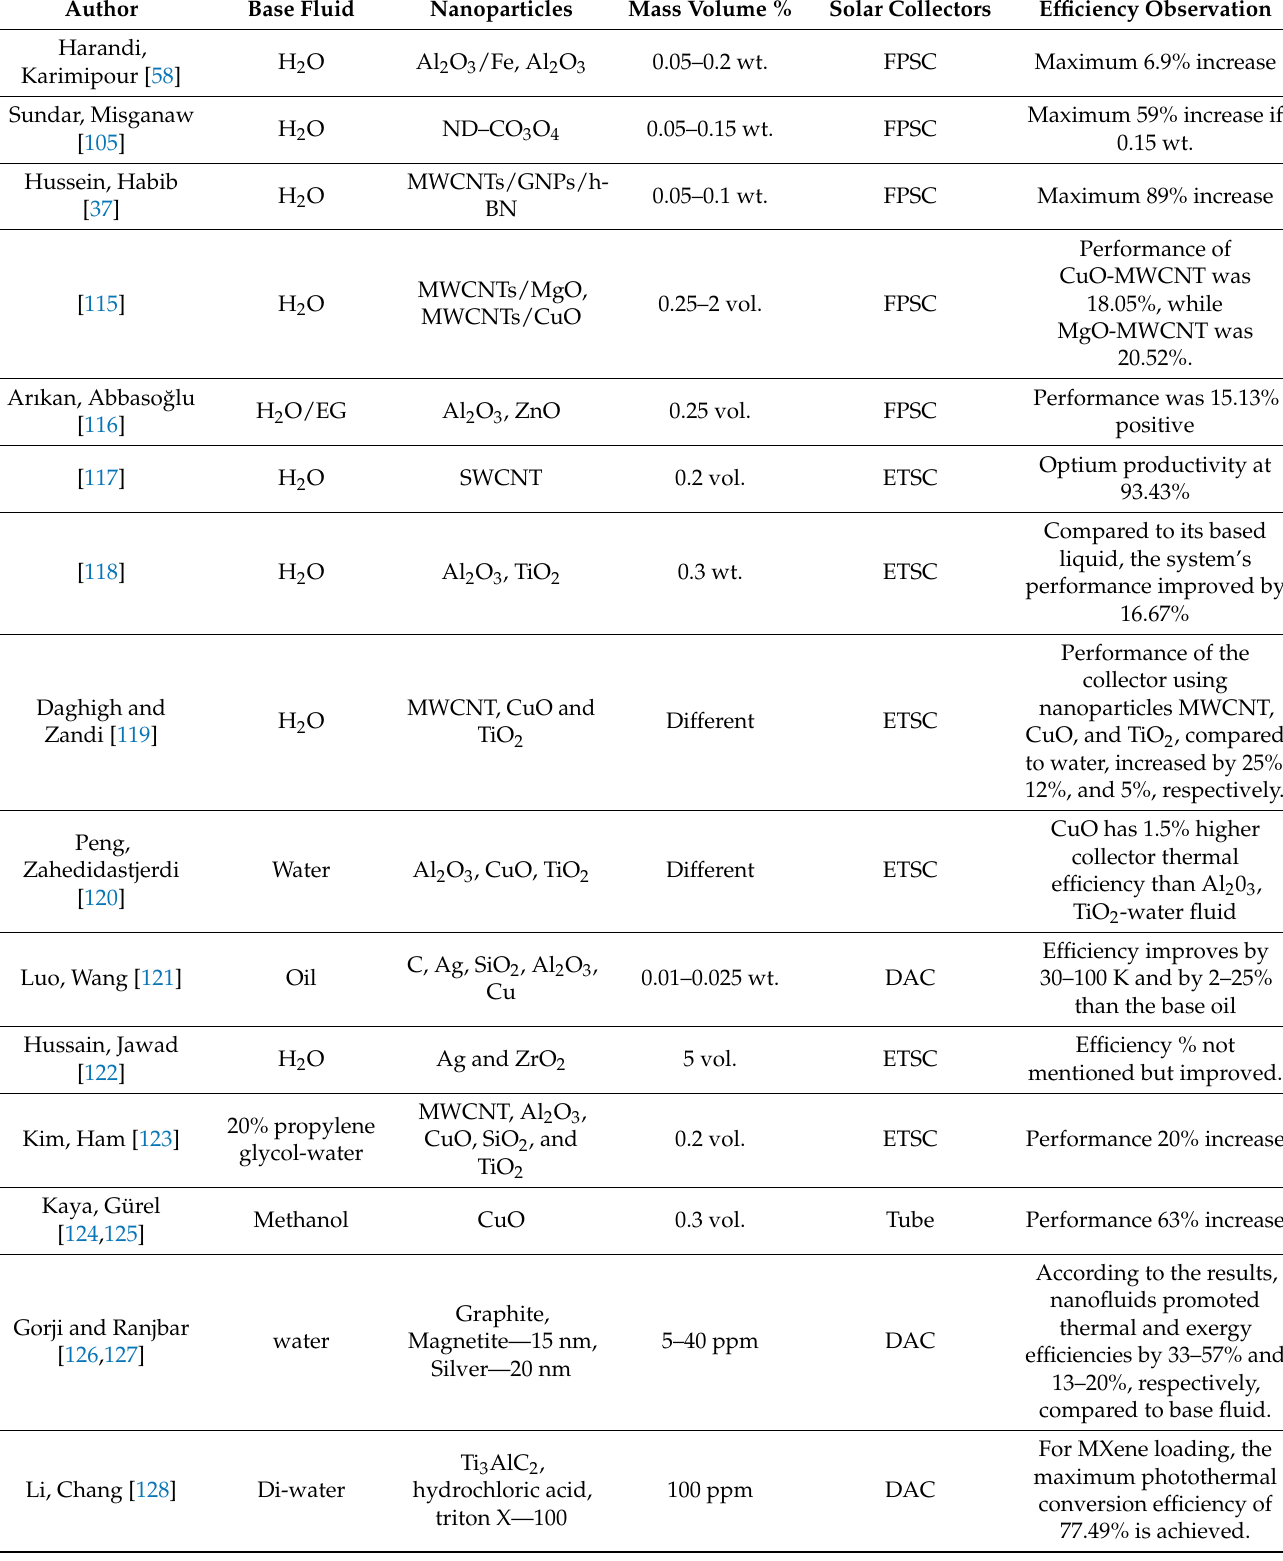
Table 3. Previous research works are based on hybrid